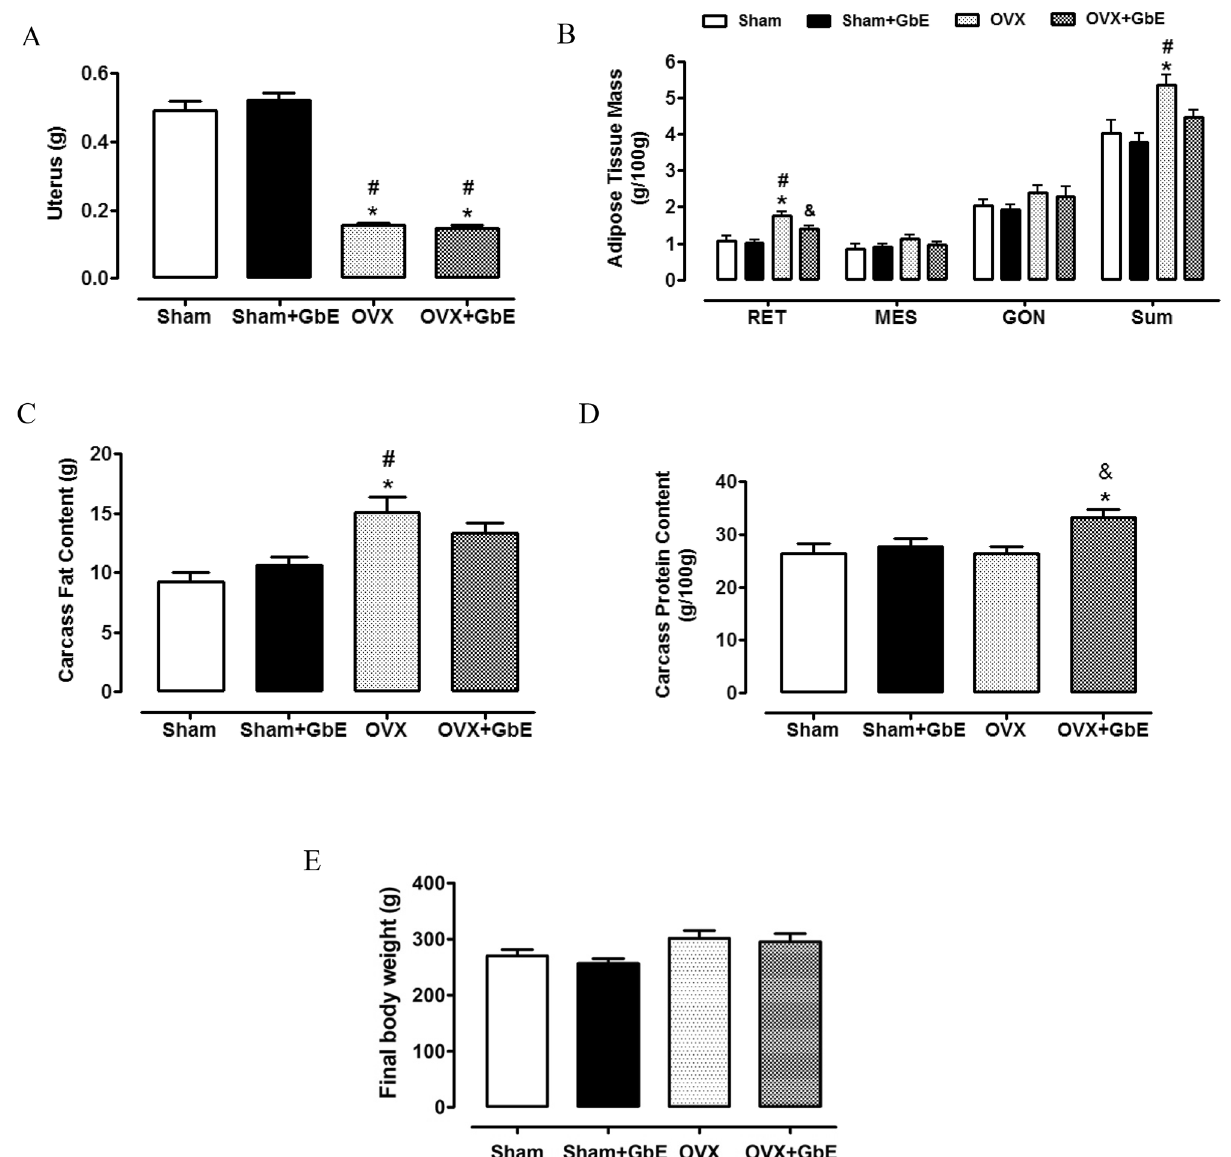
Figure 4. Body composition after GbE therapy. ( A ) Uterus (g) and ( B ) adipose tissue relative mass (g/100 g) of Sham (n = 10–11), Sham + GbE (n = 10–11), OVX (n = 10–11) and OVX + GbE rats (n = 10–13); ( C ) carcass fat (g) and ( D ) carcass protein content (g/100 g) of Sham (n = 5), Sham + GbE (n = 5–6), OVX (n = 7) and OVX + GbE rats (n = 5); ( E ) final body weight (g) of Sham (n = 8–9), Sham + GbE (n = 10–11), OVX (n = 9–10) and OVX + GbE rats (n = 9–10).*p ≤ 0.05 vs. Sham; # p ≤ 0.05 vs. Sham + GbE; & p ≤ 0.05 vs. OVX. RET